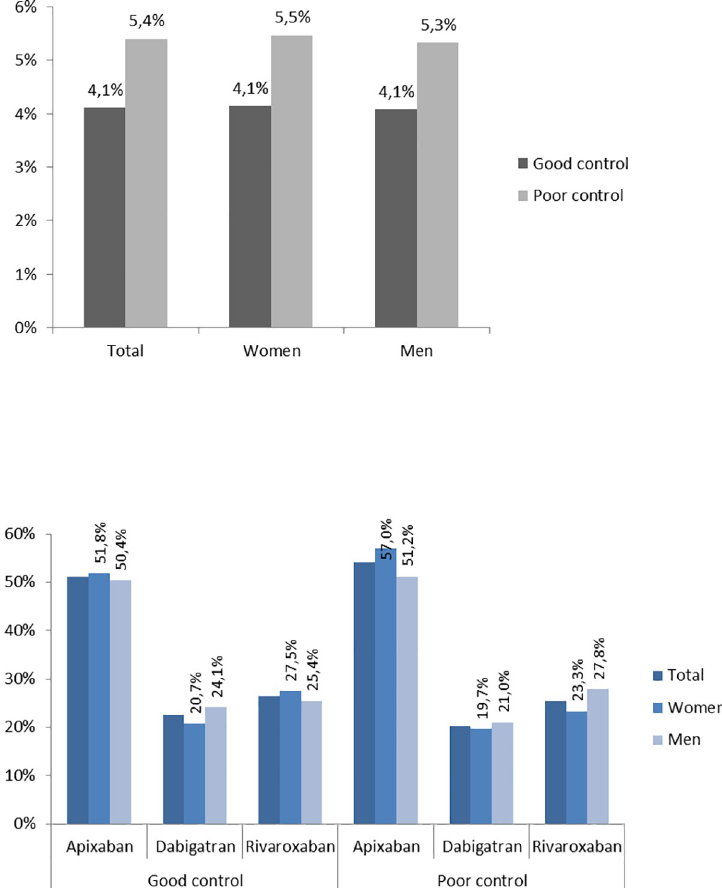
Fig 2. Percentage of switching to NOAC in 2016 by sex and quality of INR control, using Rosendaal’s TTR and TTR � 65% threshold (2a) and percentage of switching to the different NOACS in 2016 by sex and quality of INR control, using Rosendaal’s TTR and TTR � 65% threshold